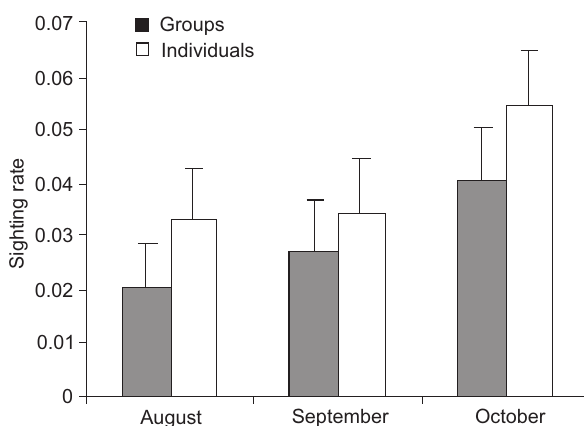
Figure 5. Seasonal variation in sighting rate (groups/nm and indi- viduals/nm) of minke whales off northeastern